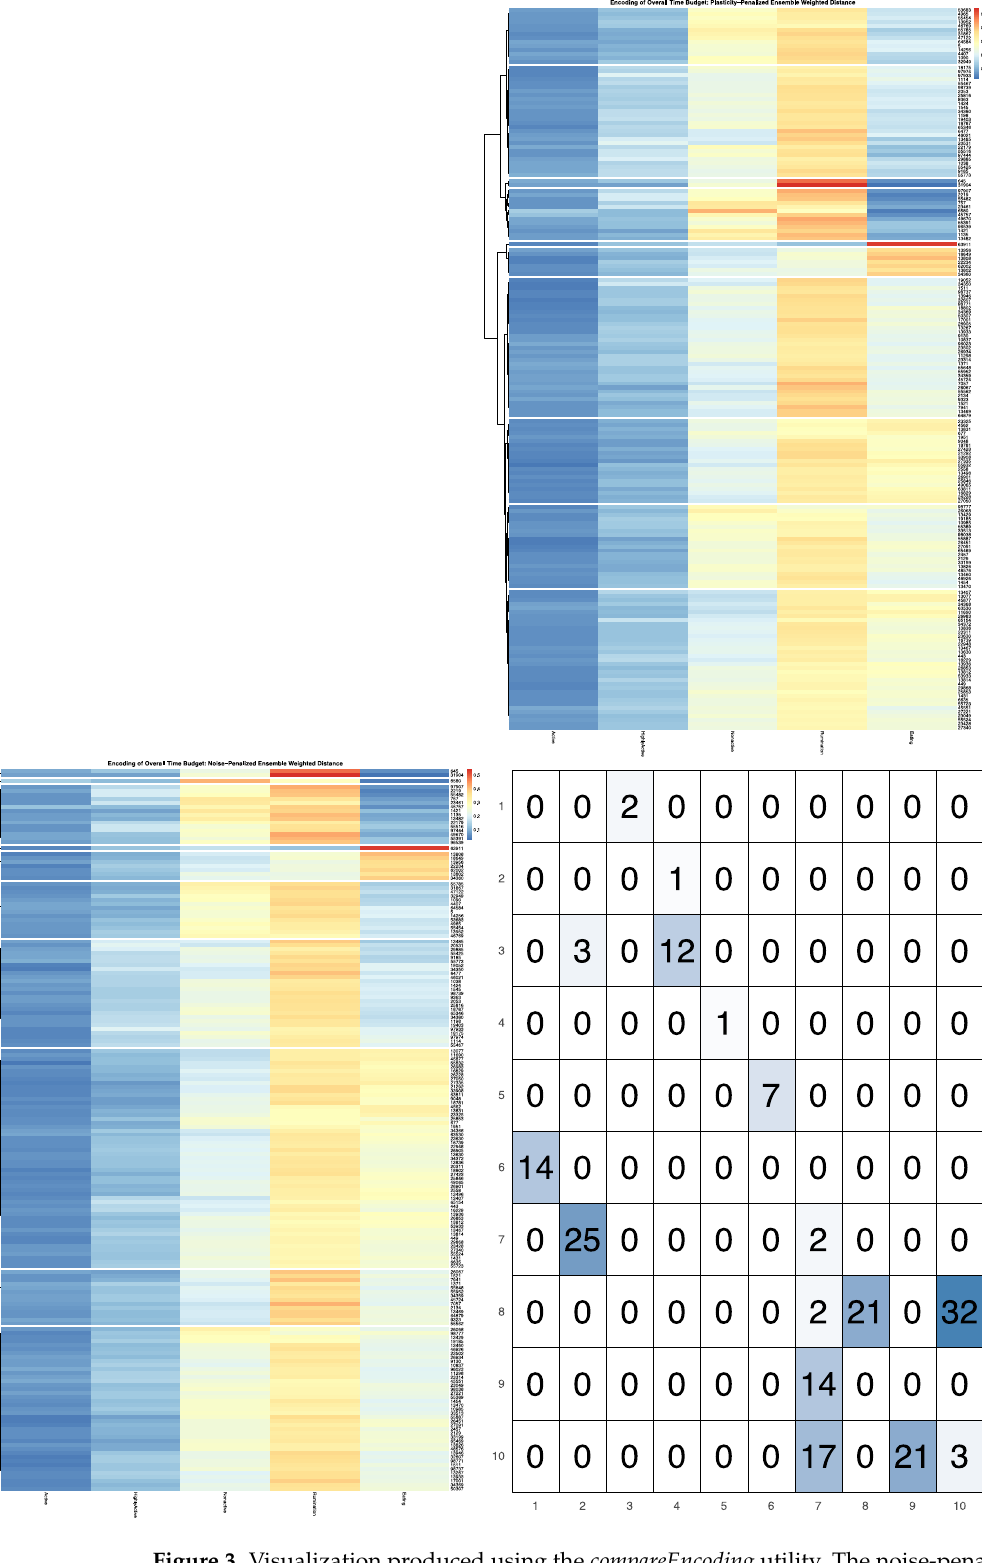
Figure 3. Visualization produced using the compareEncoding utility. The noise-penalized encoding is represented on the row axis and the plasticity-penalized encoding is represented on the column axis. Clusters in either heatmap are numbered from top to bottom, and so align directly with the corresponding row and column margins of the contingency table reading up-down and